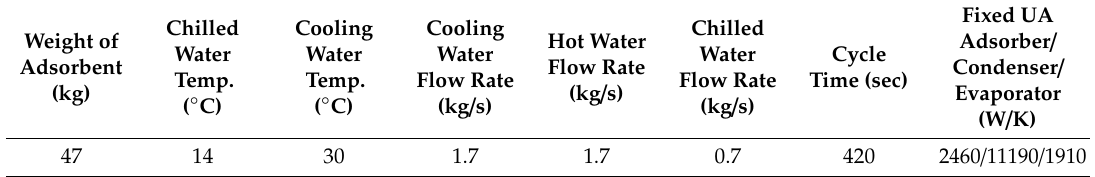
Table 3. Operating conditions of two-bed type AD